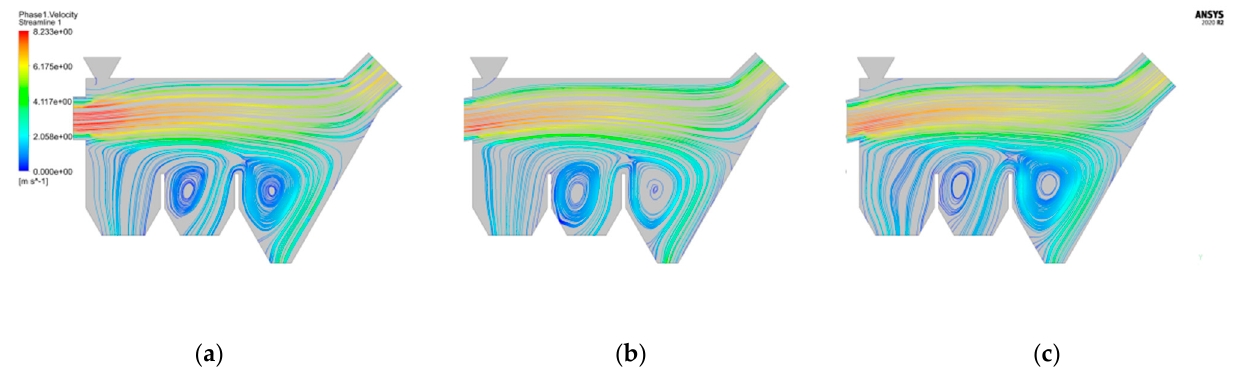
Figure 11. Streamline diagram of different types of airflow inclined angles: ( a ) 0°; ( b ) 7.5°; ( c ) 15°.